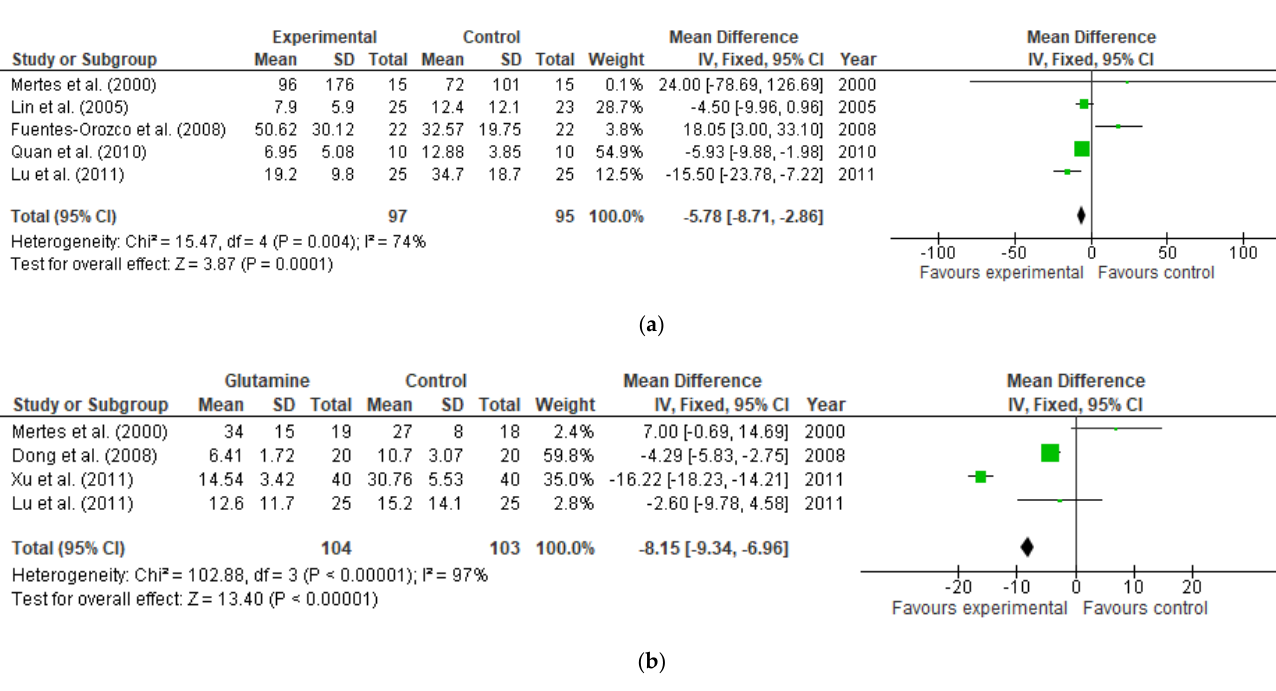
Figure 14. ( a ) IL-6 levels: fixed-effects meta-analysis and forest plot from studies providing supplementation of glutamine ( b ) TNFα levels: fixed-effects meta-analysis and forest plot from studies providing supplementation of glutamine.